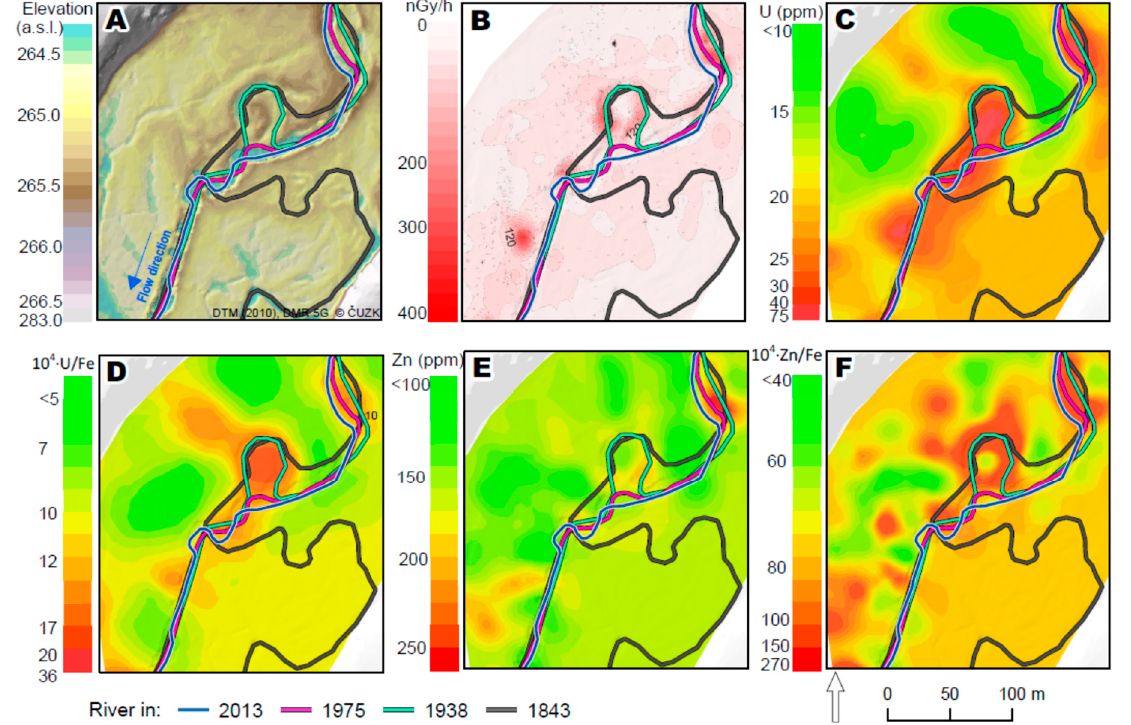
Figure 8. The AT1-Hradˇcany study area. Digital terrain model (panel A ), gamma activity map (panel B ), XRF maps of U (panel C ) and the U/Fe ratio (panel D ), and XRF maps of Zn (panel E ) and the Zn/Fe ratio (panel F ). Historical channel positions are also shown.